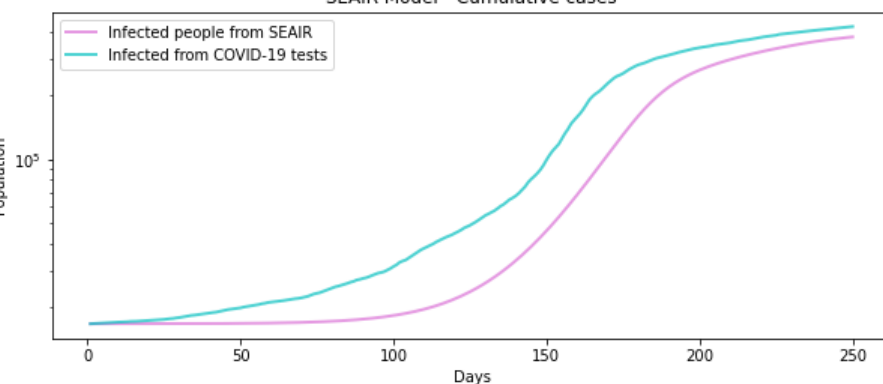
Figure 7. Comparison of cumulative infected people between SEAIR model and COVID-19 tests in Austria’s second wave after applying the best vaccination plan